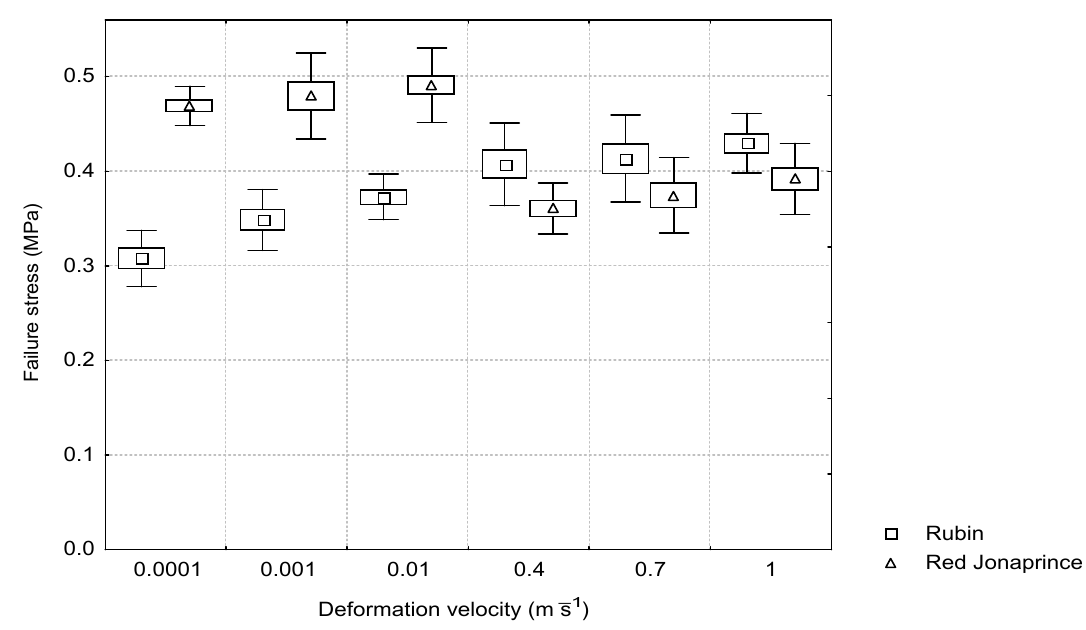
Figure 7. Relationship between the failure stress and the deformation velocity for the two apple cultivars.